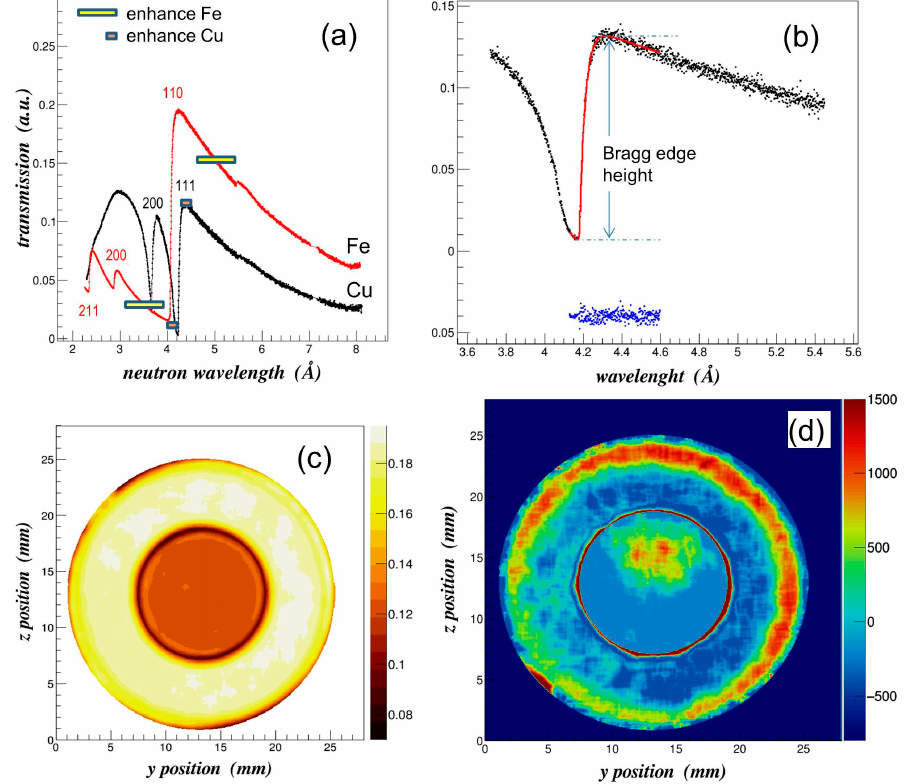
Figure 11. ( a ) Bragg edge spectra of Cu and Fe; ( b ) fit of single Bragg edge; ( c ) phase fraction map based on Bragg edge heights; ( d ) relative Bragg edge positions of Fe and Cu.